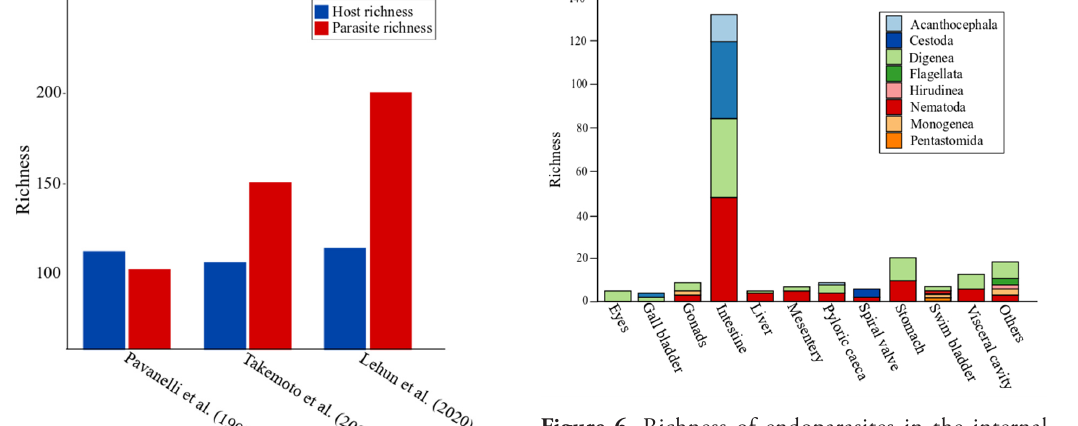
Figure 6. Richness of endoparasites in the internal organs and regions of the hosts in the upper Paraná River